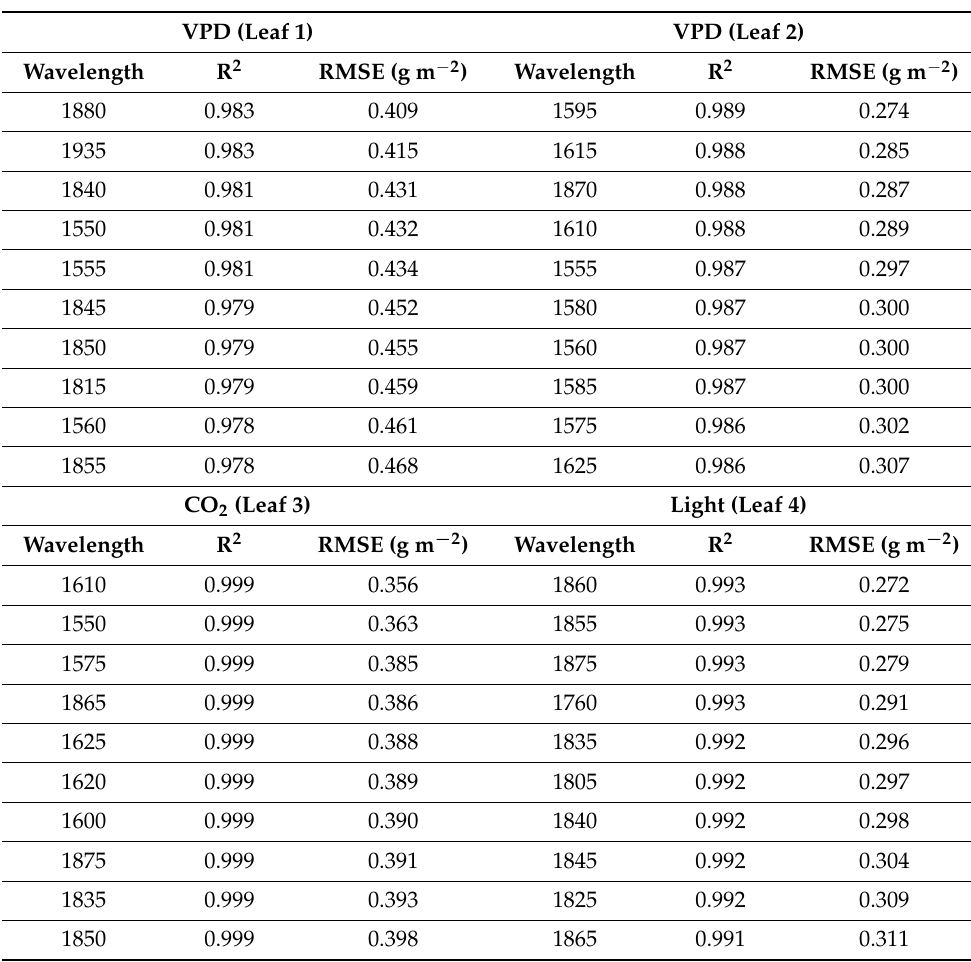
Table A1. Coefficient of determination (R 2 ) and root mean square error (RMSE) for the top 10 most accurate linear regression model estimates of equivalent water thickness (g m − 2 ) using single wavelength spectral reflectance under incremental increases in vapor pressure deficit (VPD) and constant CO 2 concentrations and light intensity (Leaf 1 and 2), light intensity and constant levels of VPD and CO 2 concentrations (Leaf 3), and D) CO 2 concentrations and constant levels of VPD and light intensity (Leaf